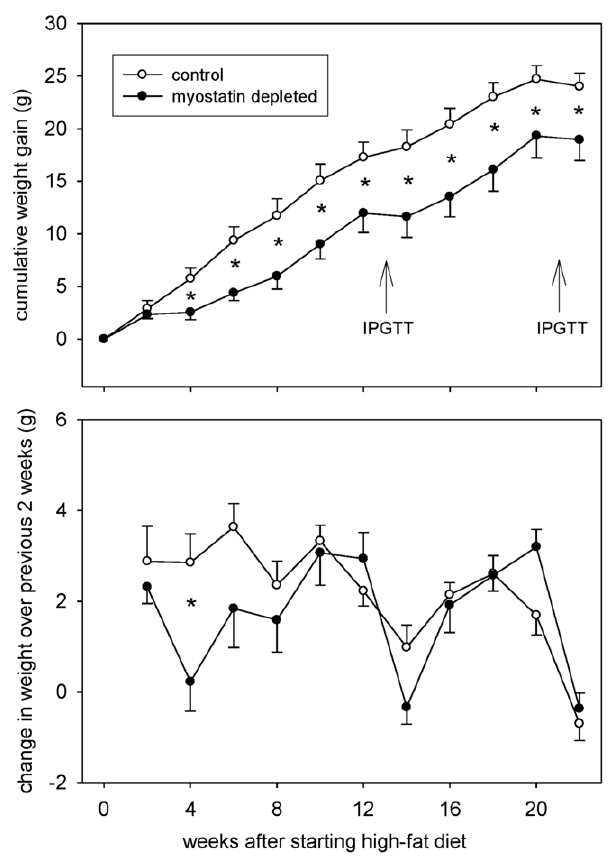
Figure 1. Mean ( ± SEM) change in total body mass. Top panel shows cumulative weight gains after changing dietary fat from 13% to 60% of energy, and lower panel shows biweekly weight changes independent of previous measures. IPGTT=intraperitoneal glucose tolerance test. * P , 0.05 (adjusted for multiple comparisons) for difference between normal and myostatin-depleted.